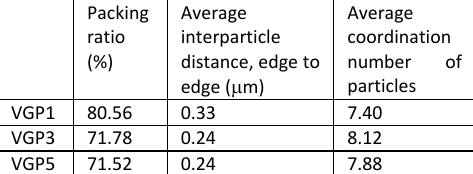
Figure 11. Calculated interparticle distance. Table 7. Results of